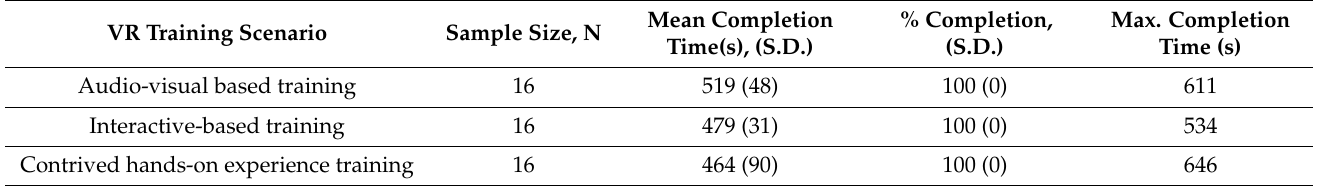
Table 1. Comparison of the quiz completion time between the developed VR training